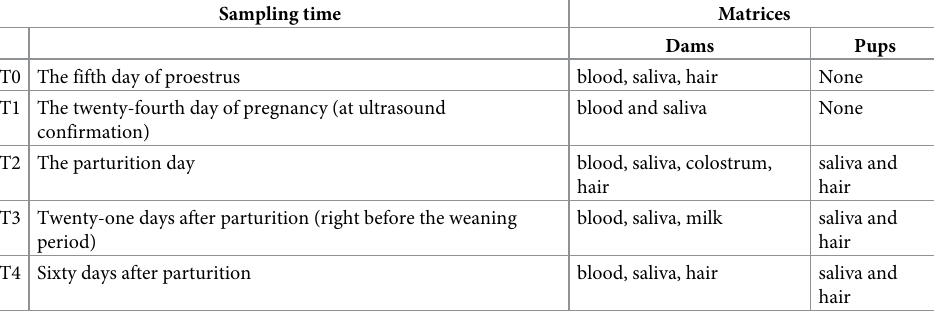
Table 1. Collection times of matrices in dams and